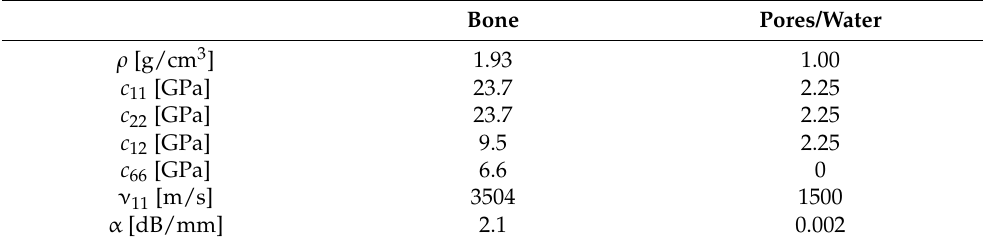
Table 2. Tissue material properties of bone and pores used for the numerical model. Mass density ρ , and c ij (i.e., the coefficients of a transverse isotropic stiffness tensor were taken from [27] and the absorption value α was obtained from [26]) (adapted from [19] under the Creative Commons Attribution 4.0 license).